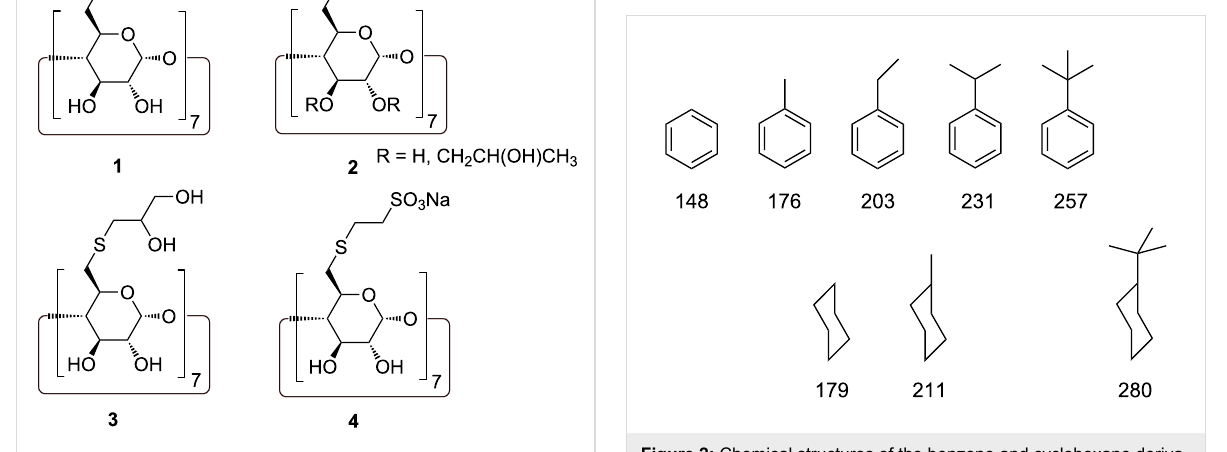
Figure 1: Chemical structures of β -CD 1 , hydroxypropyl- β -CD 2 , and β -CD-thioethers 3 and 4 .